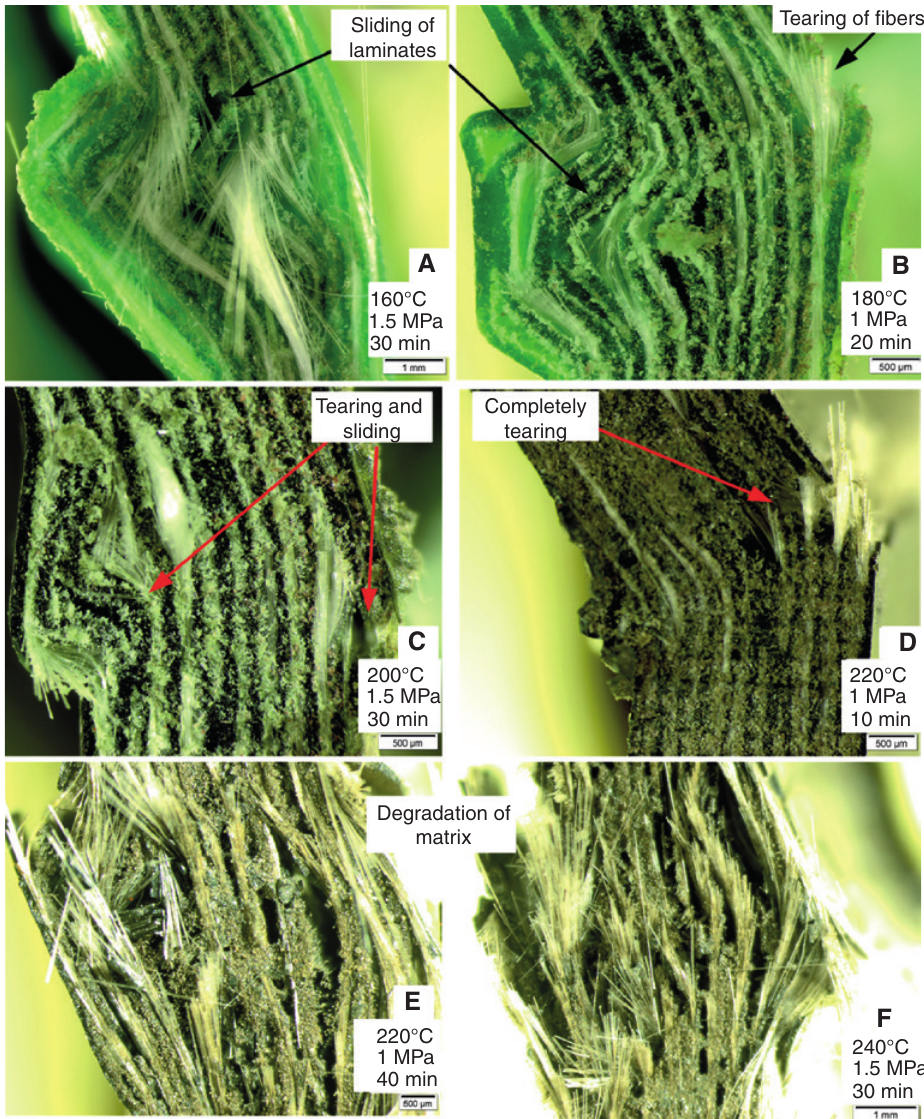
Figure 9: Optical microscope images of the samples failure mechanisms (inter-laminar sliding, fibers fracture, and matrix degradation are the main failure